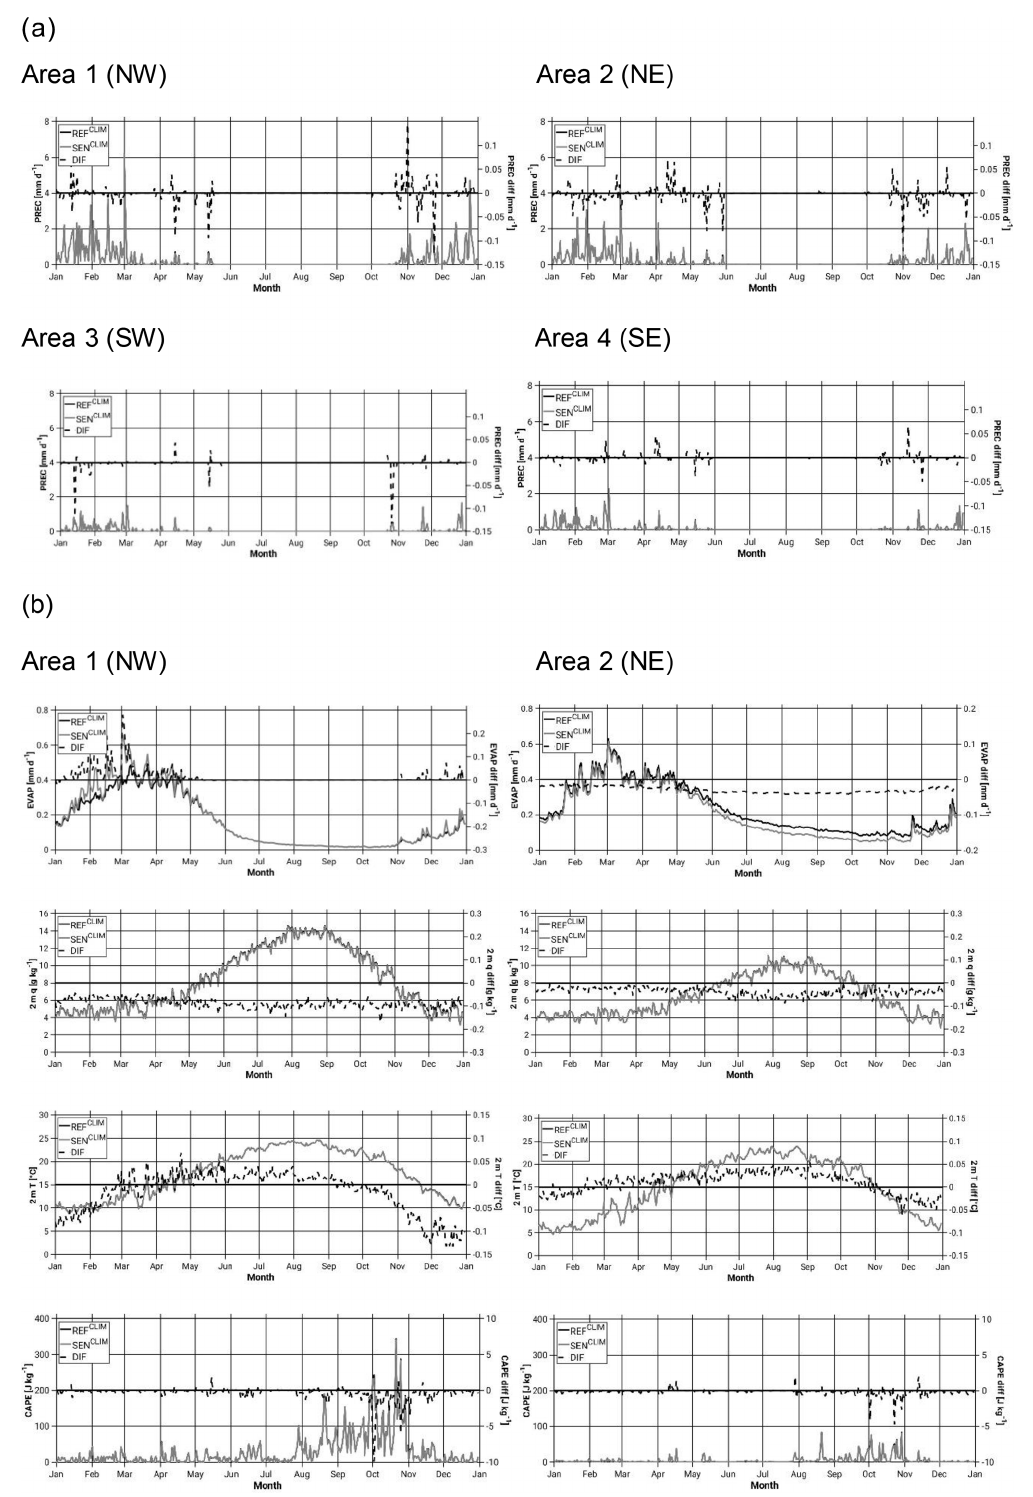
Figure 3. Annual cycle of the areal daily averages of and differences in (black dashed lines; SEN and REF) (a) precipitation for areas A1, A2, A3 and A4 (see Fig. 1b), (b) evaporation, specific humidity and temperature at 2m, and CAPE for areas A1 and A2 from the REF CLIM (full black line) and the SEN CLIM (full grey line) simulations. Only land points in the study area (Fig. 1) for evaporation and all grid points for the rest of the variables and the 2004 to 2013 period are